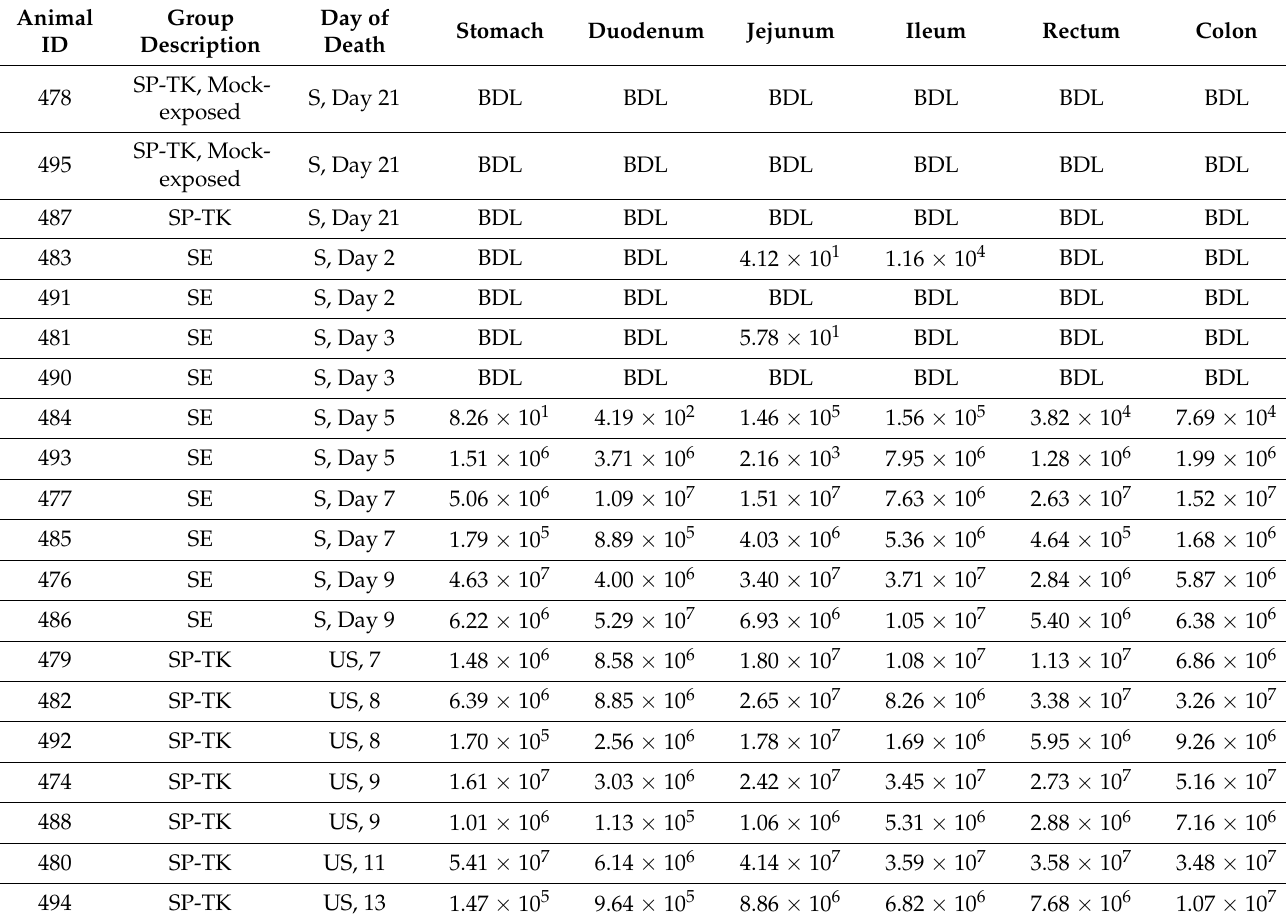
Table 2. Viral Load in Gastrointestinal Tract Tissues as Determined by Plaque Assay